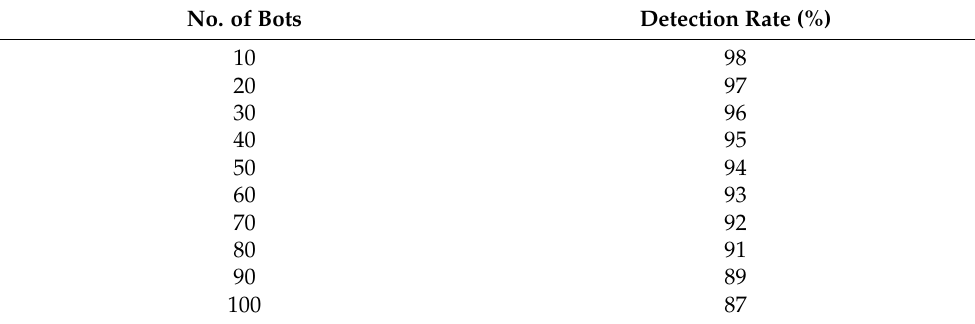
Table 3. Analysis of malicious packet detection rate. No. of Bots